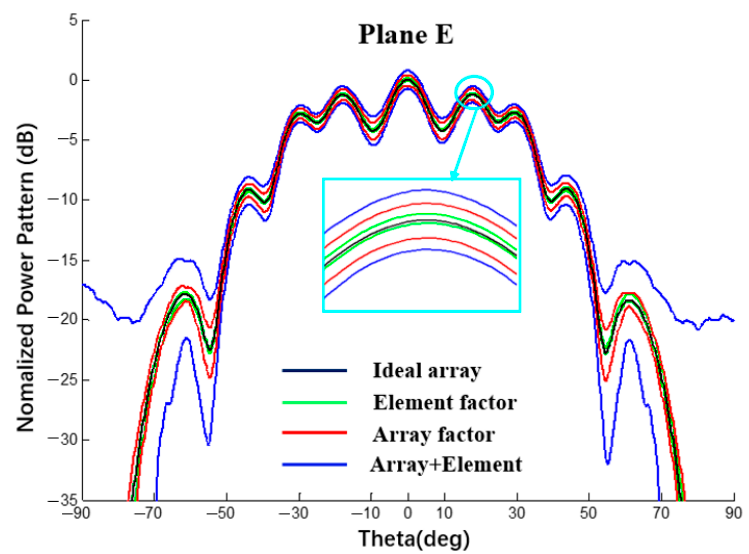
Figure 25. Interval power pattern based on the error of different factors of 1 × 10 linear arrays (uniform excitation).